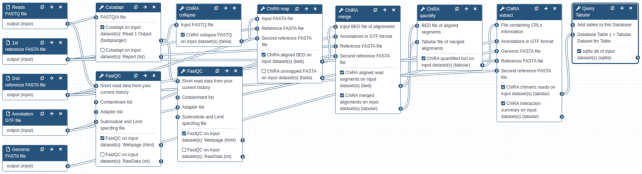

ChiRA Galaxy workflow. The workflow takes the FASTQ files that contain raw sequencing reads, process them, and produces a tabular and an SQLite database of interactions that are ready to be visualized by ChiRAViz.